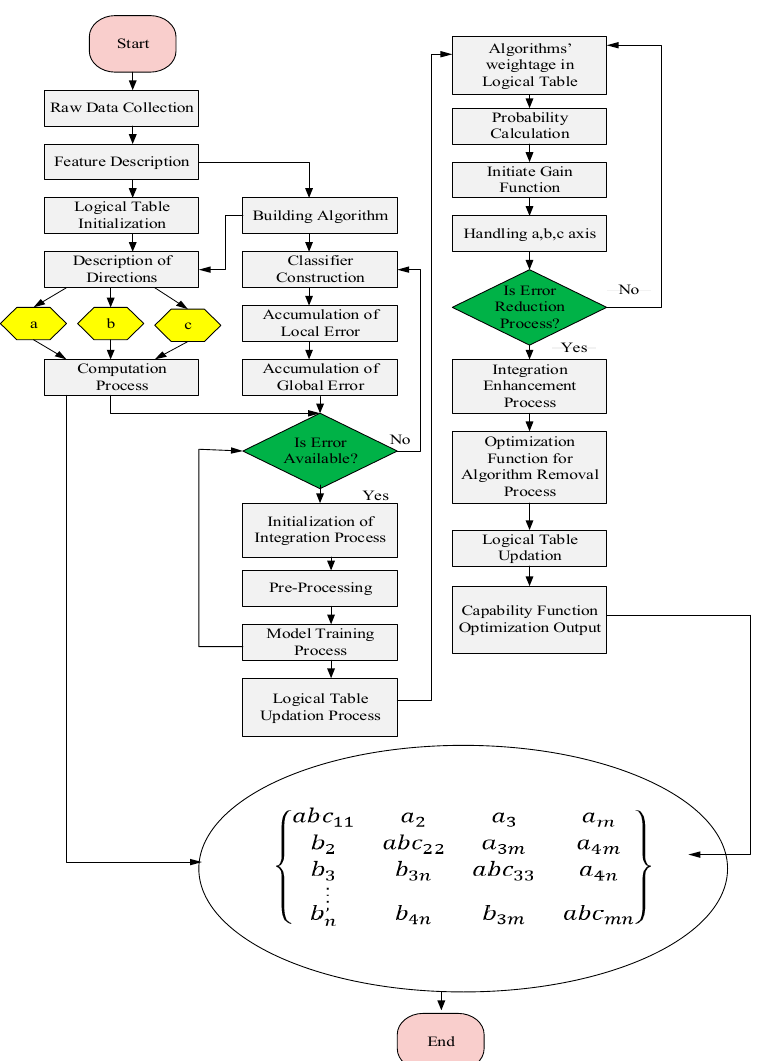
Figure 9. Illustration of elevated level for proposed PTIP